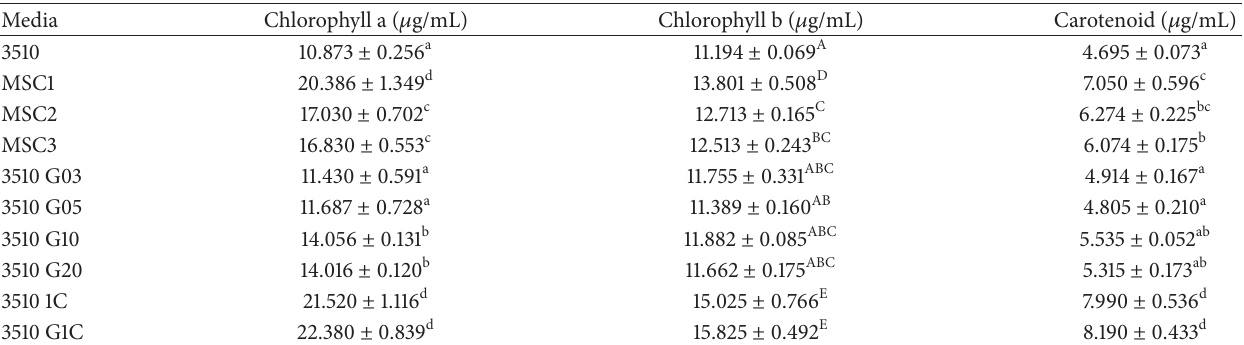
Table 7: Effects of activated charcoal and glutamine on concentration of leaf pigments in yellow C. crotalifera (CCY).